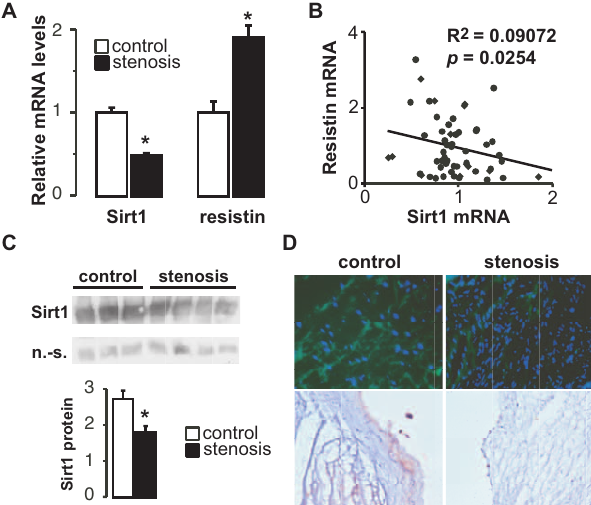
Figure 1. Low Sirt1 levels in aortic stenosis are inversely associated with resistin expression. A , Levels of Sirt1 and resistin mRNA levels in aortic valves from 11 control and 51 patients with AS. Gene mRNA was normalized to the housekeeping gene L27. B , Linear regression between relative resistin and Sirt1 mRNA levels. Each point represents a single patient. C , Sirt1 protein levels in aortic valves from control and AS patients. Bar graph depicts the signal intensity relative to that of a non-specific band. D , Sirt1 protein levels in aortic valve tissue from control and AS patients as visualized by immunofluores- cence (IF, top panels) and immunohistochemistry (lower panels). In IF, FITC (green) signals were against Sirt1, whereas Hoescht (blue) signals strain nuclei. Representative pictures are shown. In all panels, * indicates a significant difference between groups.